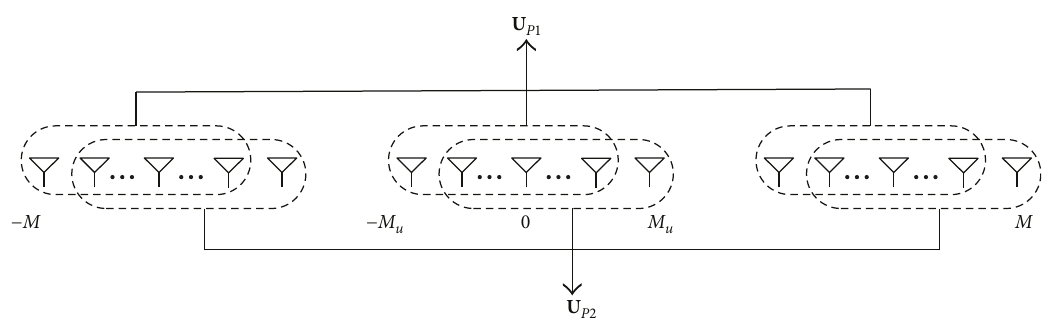
Figure 4: Construction of 2 subspace matrix elements for coarse DOA